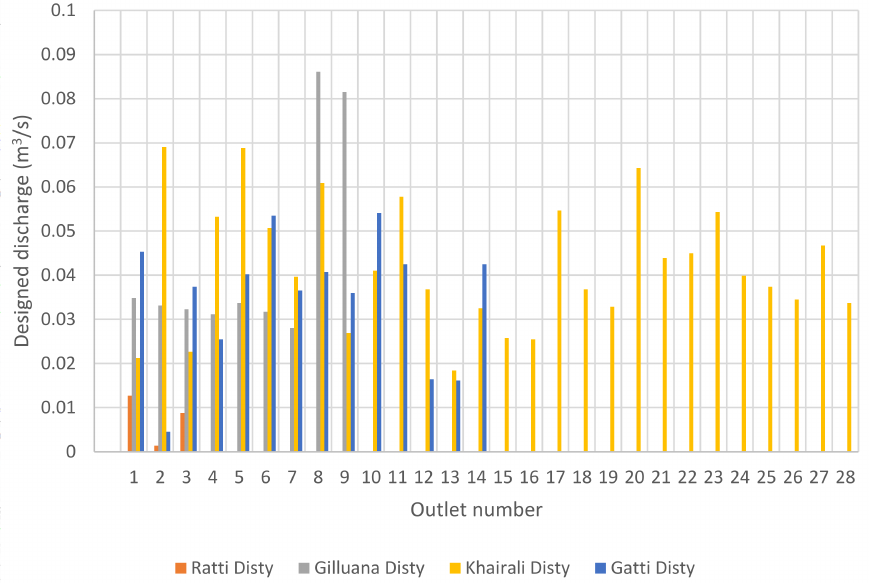
Figure 3. Designed discharge of each outlet in the selected